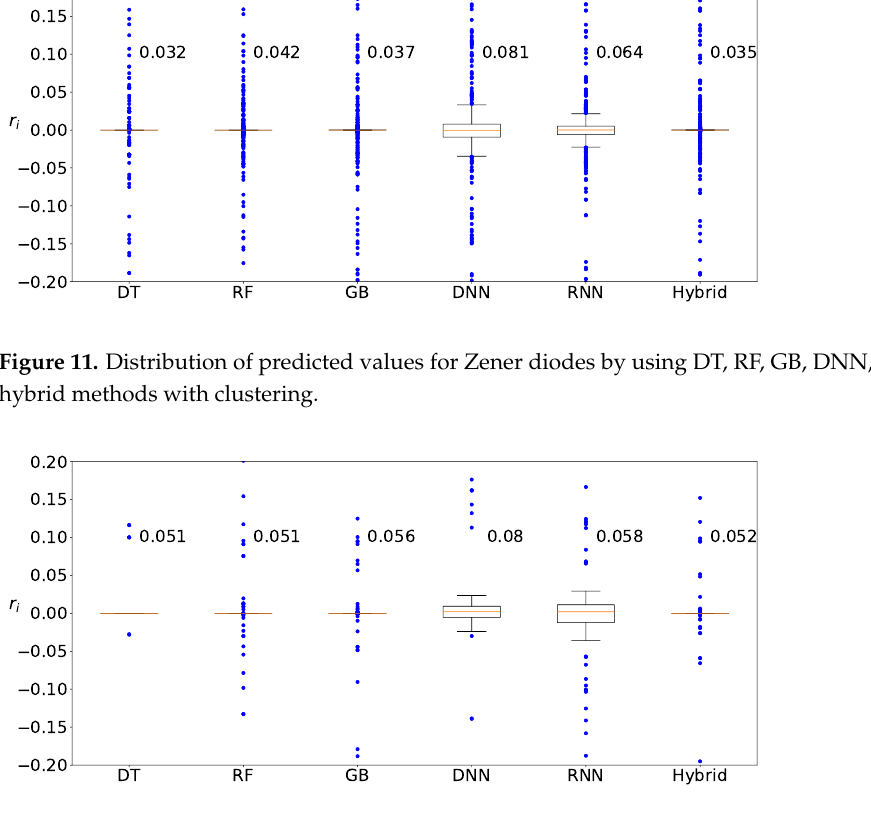
Figure 12. Distribution of predicted values for varactors by using DT, RF, GB, DNN, RNN, and hybrid methods with clustering.